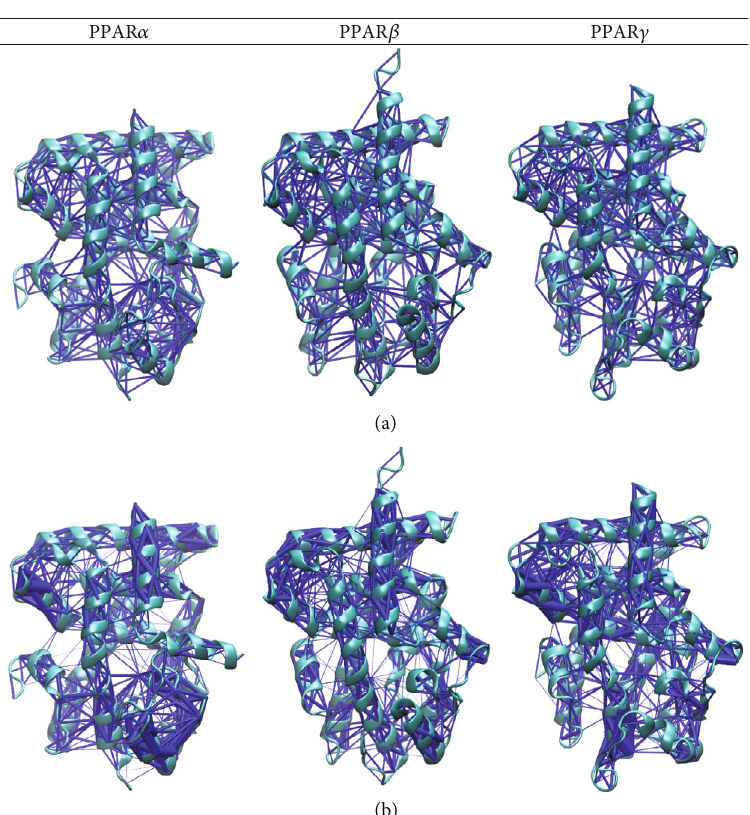
Figure 11: Unweighted (a) and weighted (b) network models of PPAR α , PPAR β , and PPAR γ